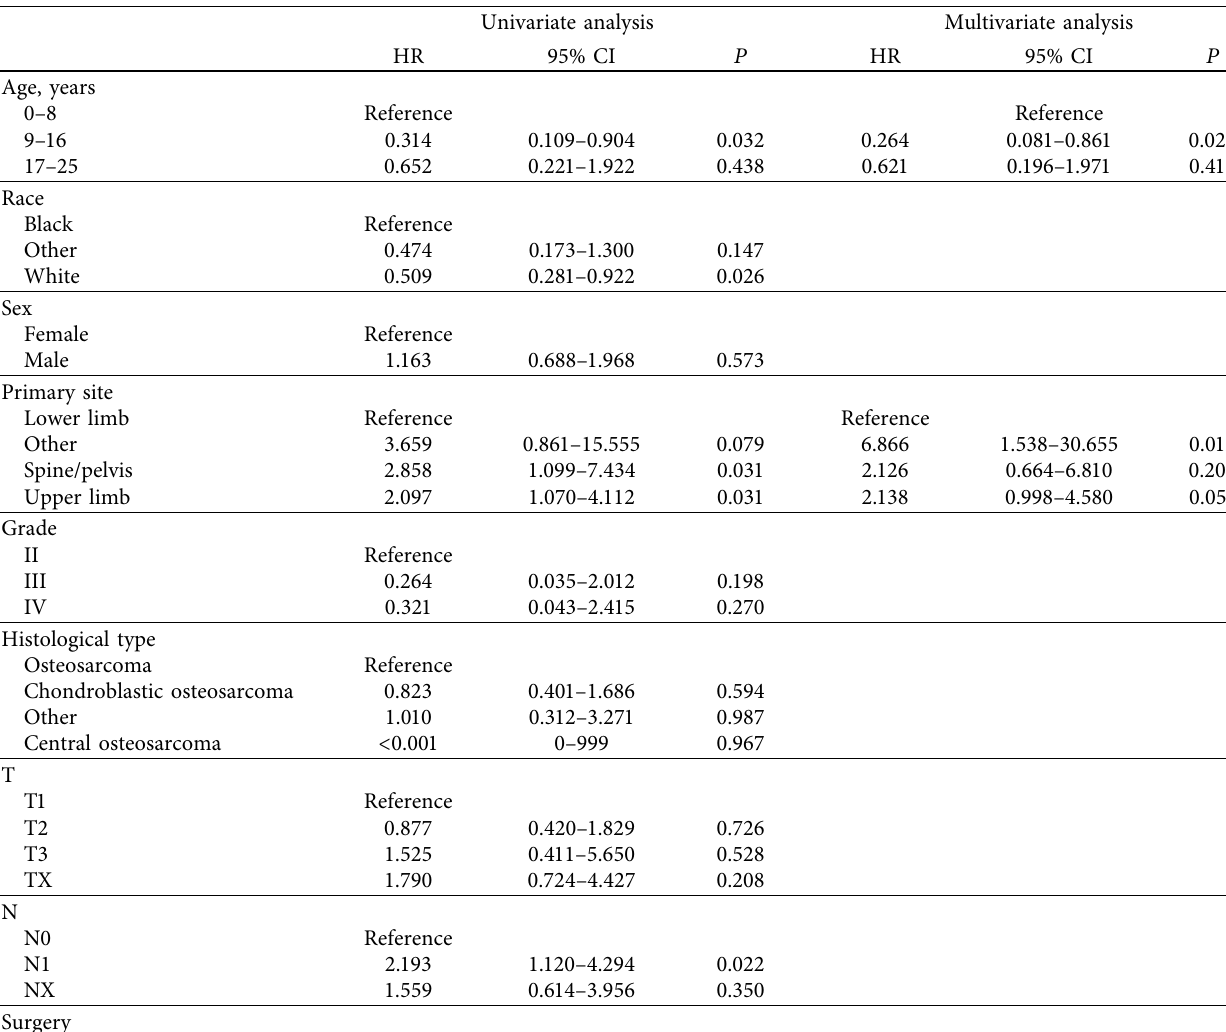
Table 4: Univariate and multivariate Cox analyses of osteosarcoma patients with